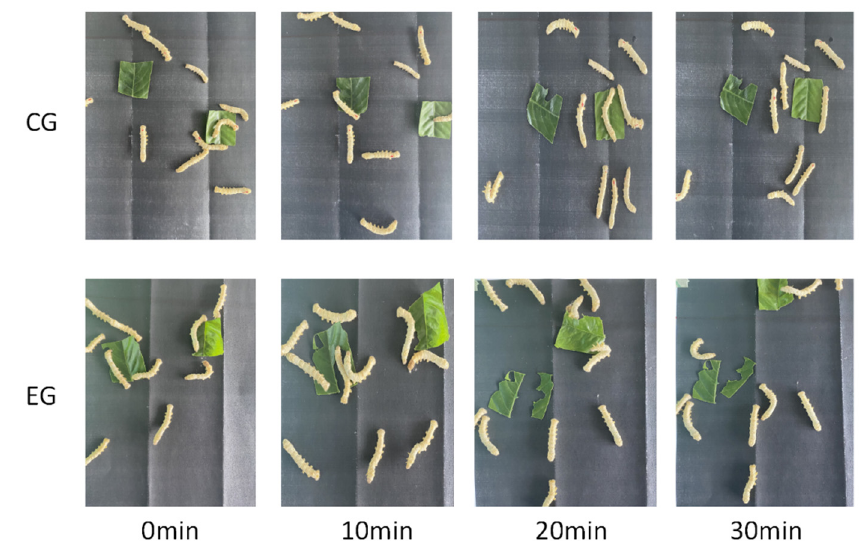
Figure 8. Bombyx mori after the injection of dsRNA and starving for 24 h, fed on gardenia leaves within 30 min. EG: experimental group; CG: control group.